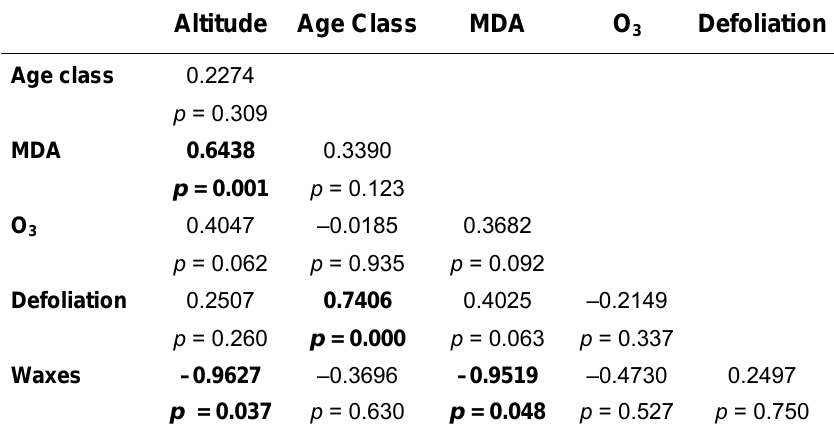
Matrix of Correlation for European